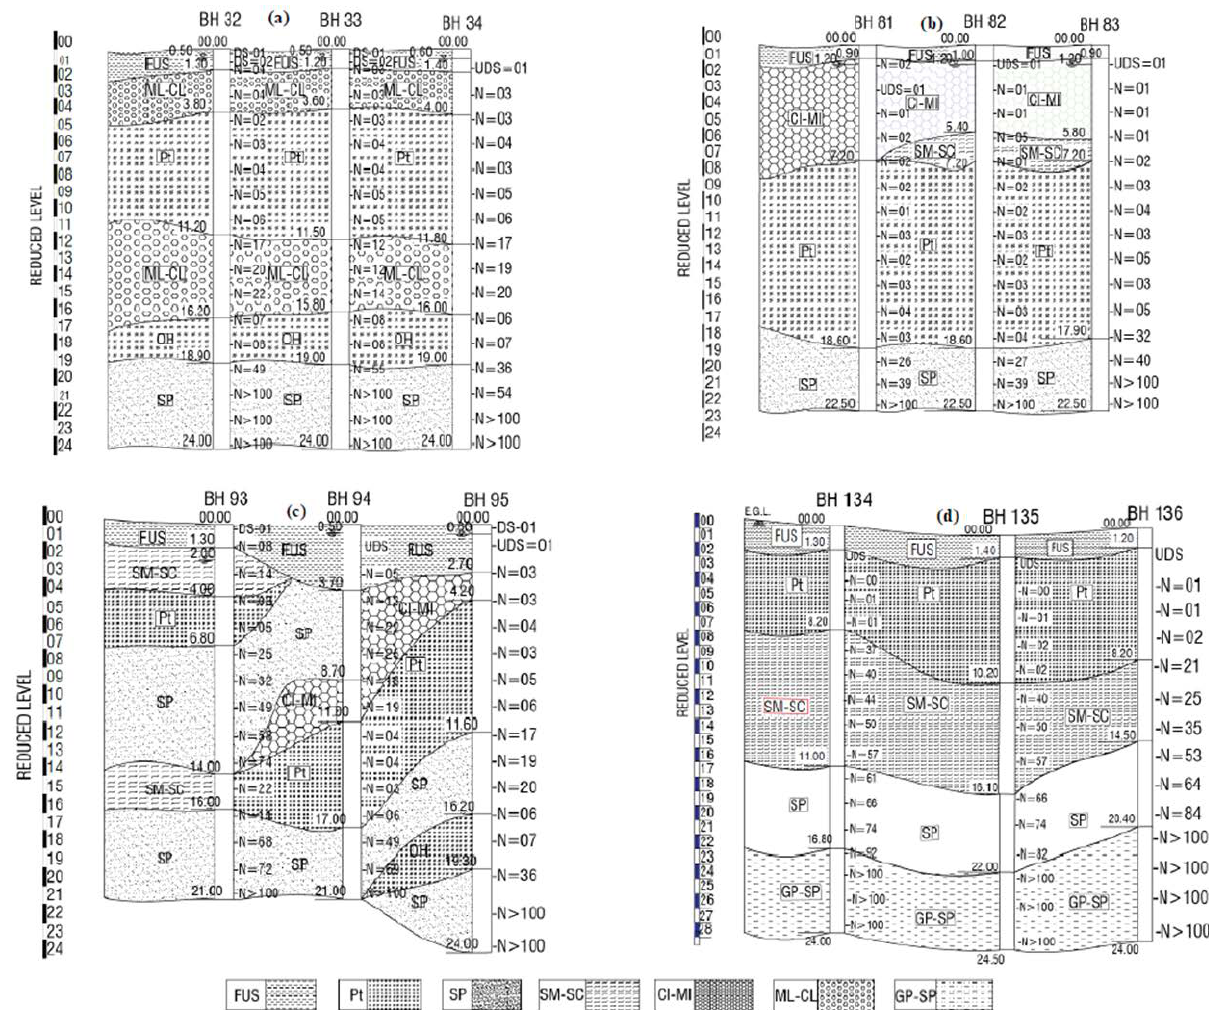
Figure 3. Sample longitudinal cross-sectional subsoil profiles having peat deposits in different zones of Agartala: (a) north zone, (b) east zone, (c) central zone, (d) south